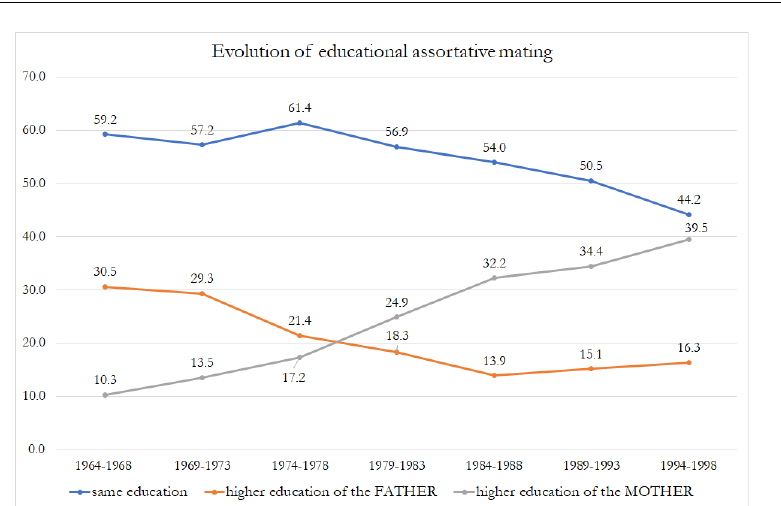
Figure 2 – Evolution of educational assortative mating (percentage distribution by mother’s co- hort). Source: Bangladesh Demographic and Health Survey